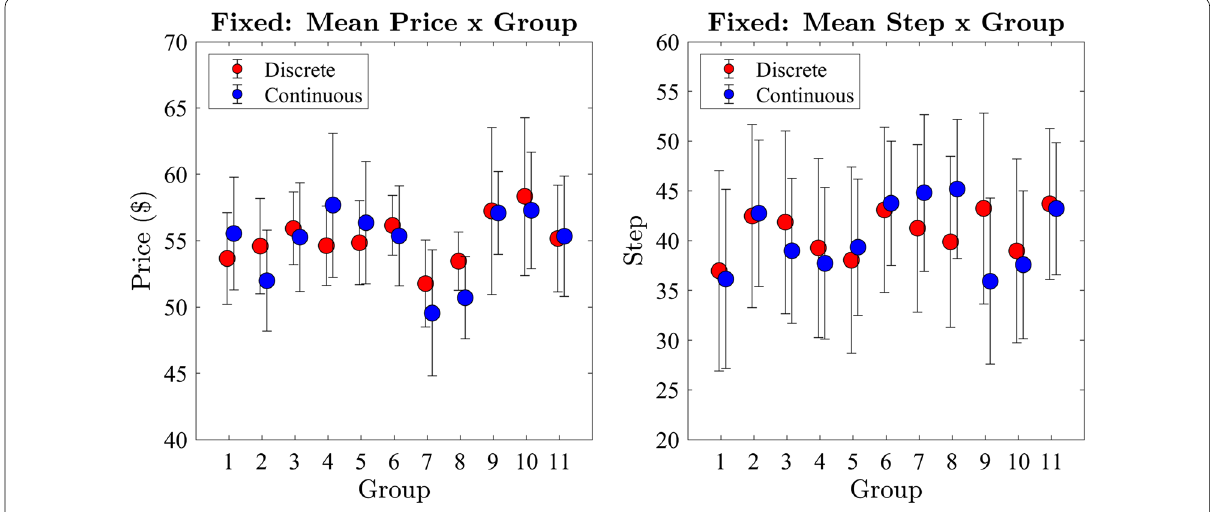
Fig. 5 Exp 1: mean price and step per